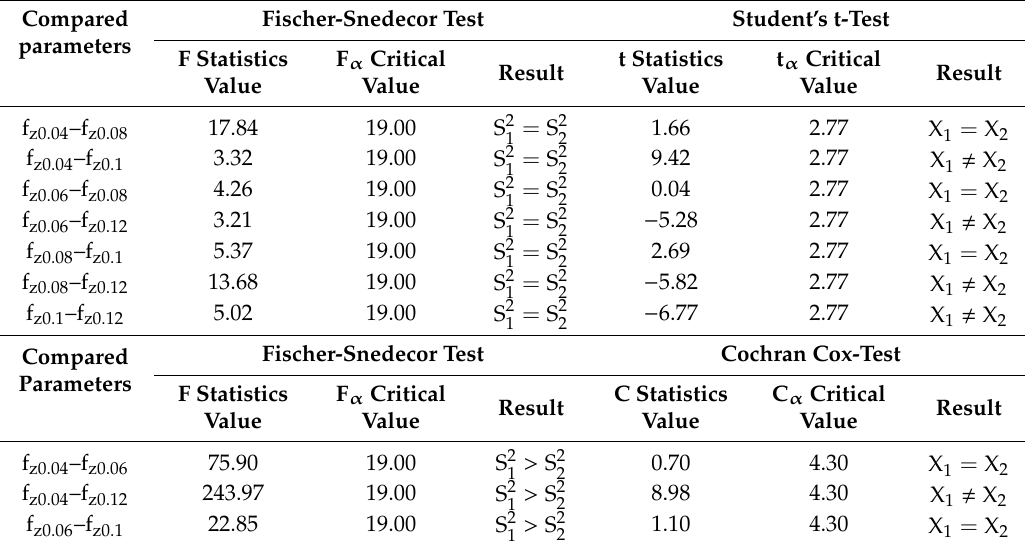
Table 9. Results of statistical analysis for f z variable during milling from aluminum alloy layer (Al/CFRP) [28].